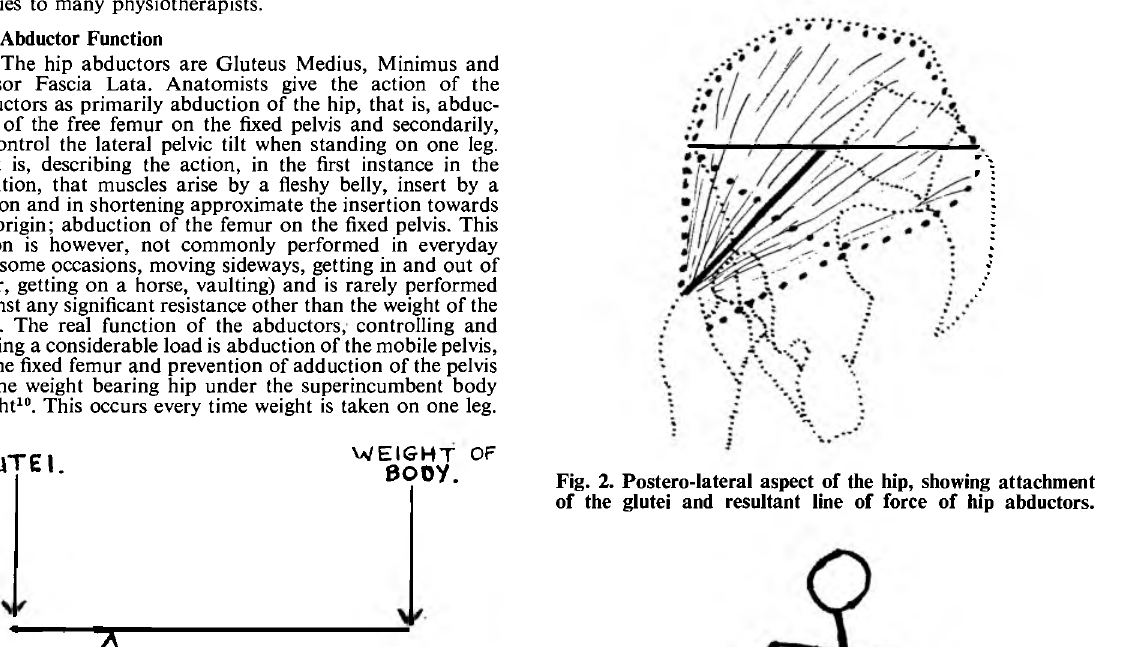
Fig. 2. Postero-lateral aspect of the hip, showing attachment of the glutei and resultant line of force of hip